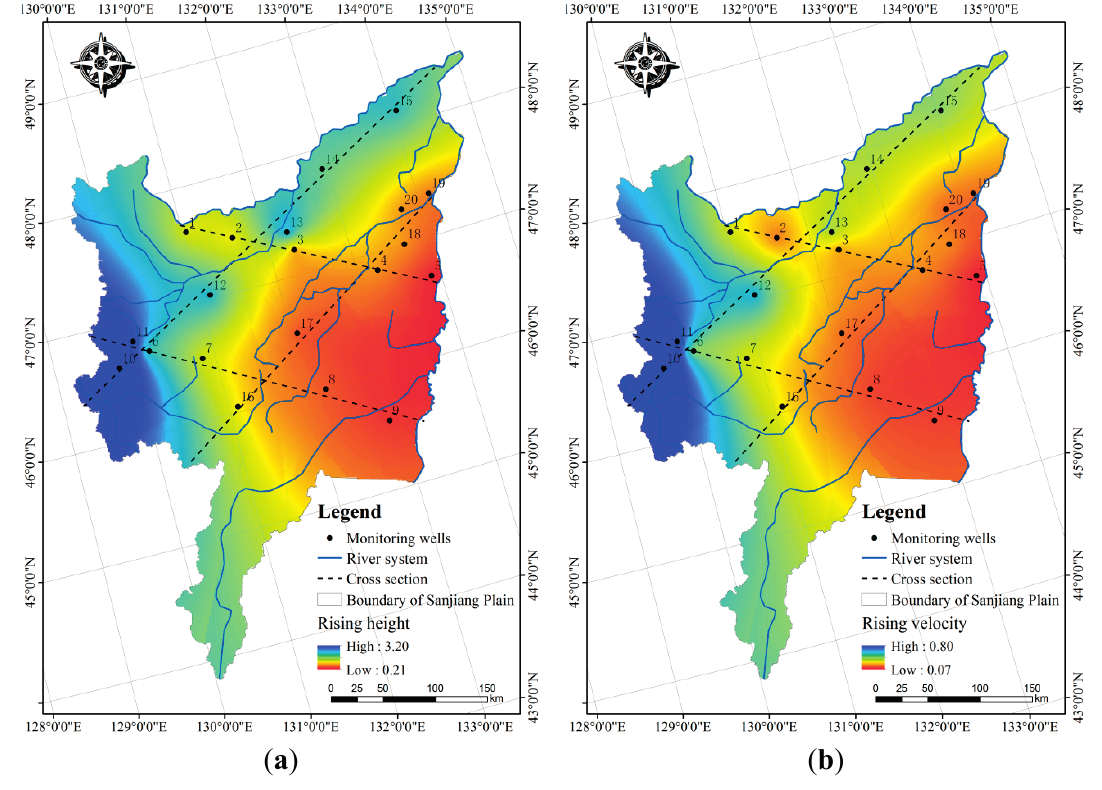
Figure 4. Groundwater rising height ( a ) and rising velocity ( b ) following the 2013 flood in the Sanjiang Plain, Northeast